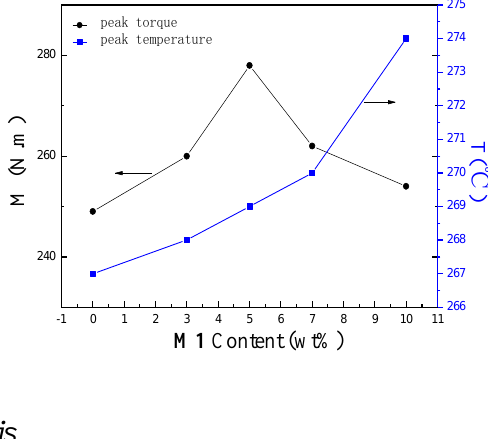
Figure 3. Effect of content of M1 on torque and temperature of modified